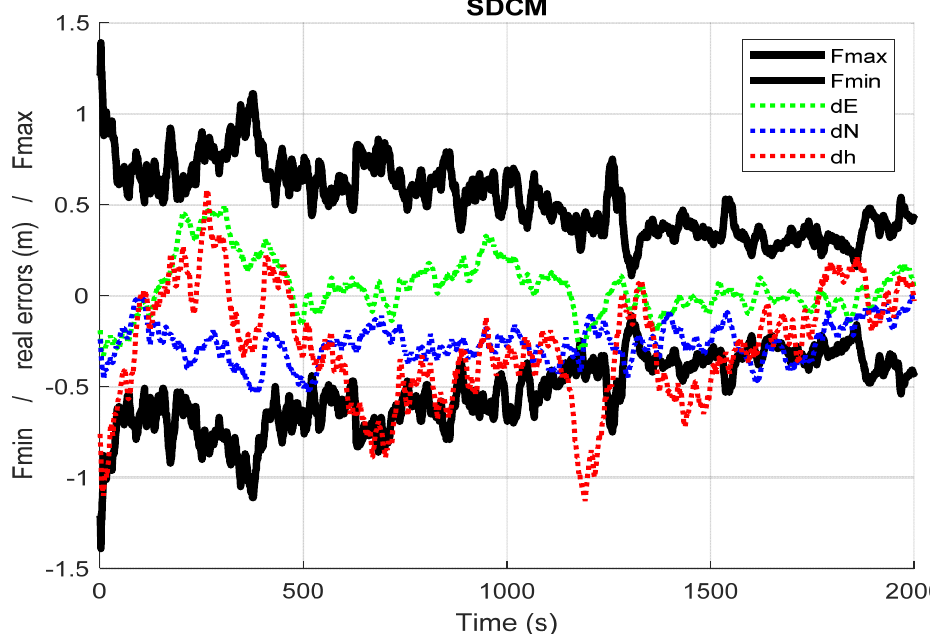
Figure 17. Confidence intervals for the calculated 3D error ( 𝐹𝑚𝑖𝑛 ; 𝐹𝑚𝑎𝑥 ) with respect to the real horizontal and vertical errors, for the dual receiver SDCM system and C1C+C1W codes.